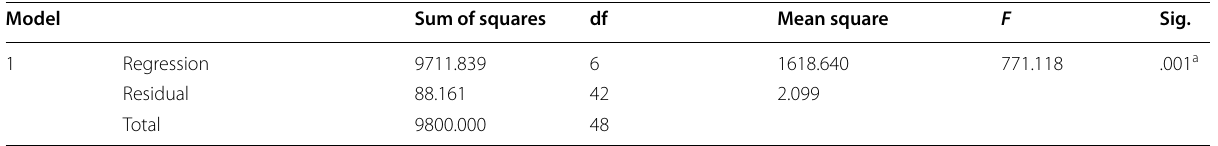
Table 10 ANOVA of the regression model for time of death